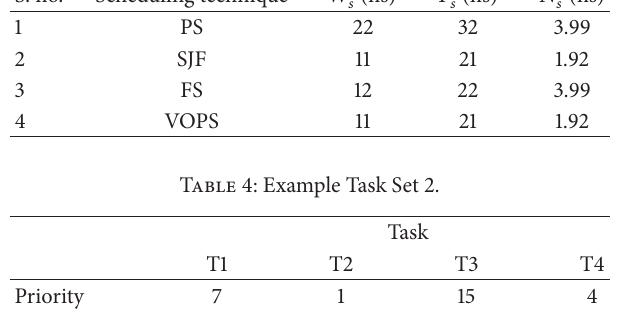
Table 5: Updated Task Set 2.